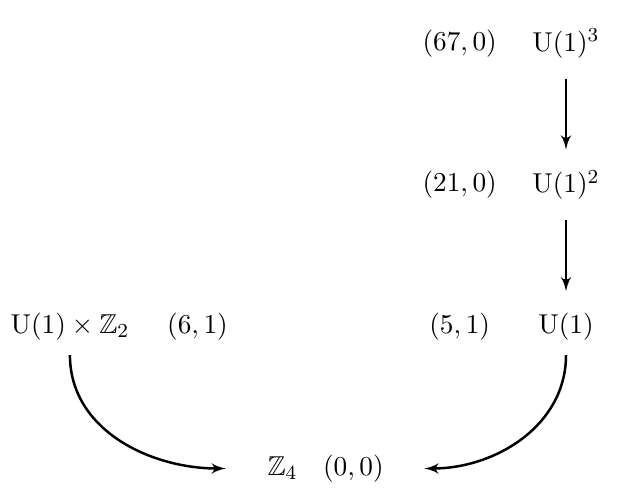
Figure 1 . The two chains of extremal transitions among complete intersection fibers that end on the generic family of bi-quadrics in P 3 . For each family we list the index of the polytope, the index of the nef partition and the generic gauge